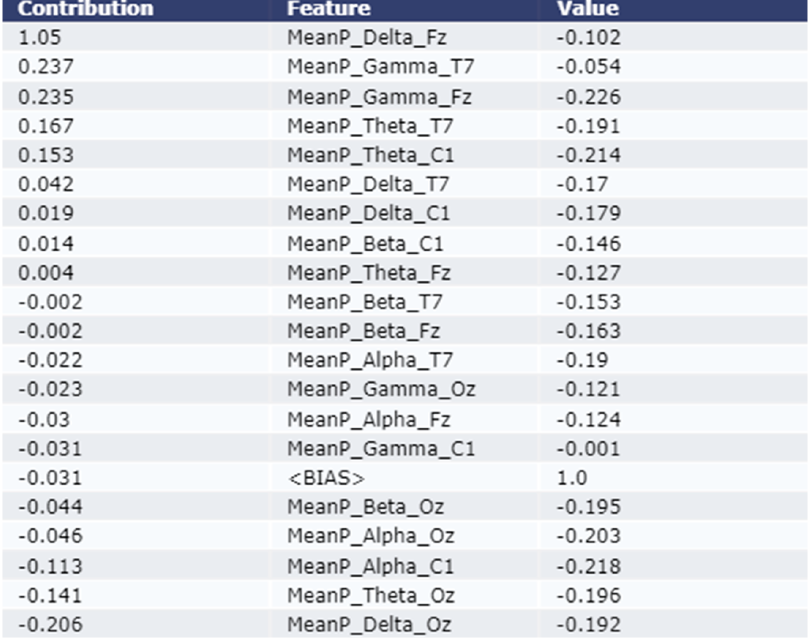
Figure 4. Explanation of the local contribution of EEG features through the Eli5 model in classifying a single test instance (predicted class = Stroke) using the XGBoost model. The importance of the features is denoted by positive contribution.